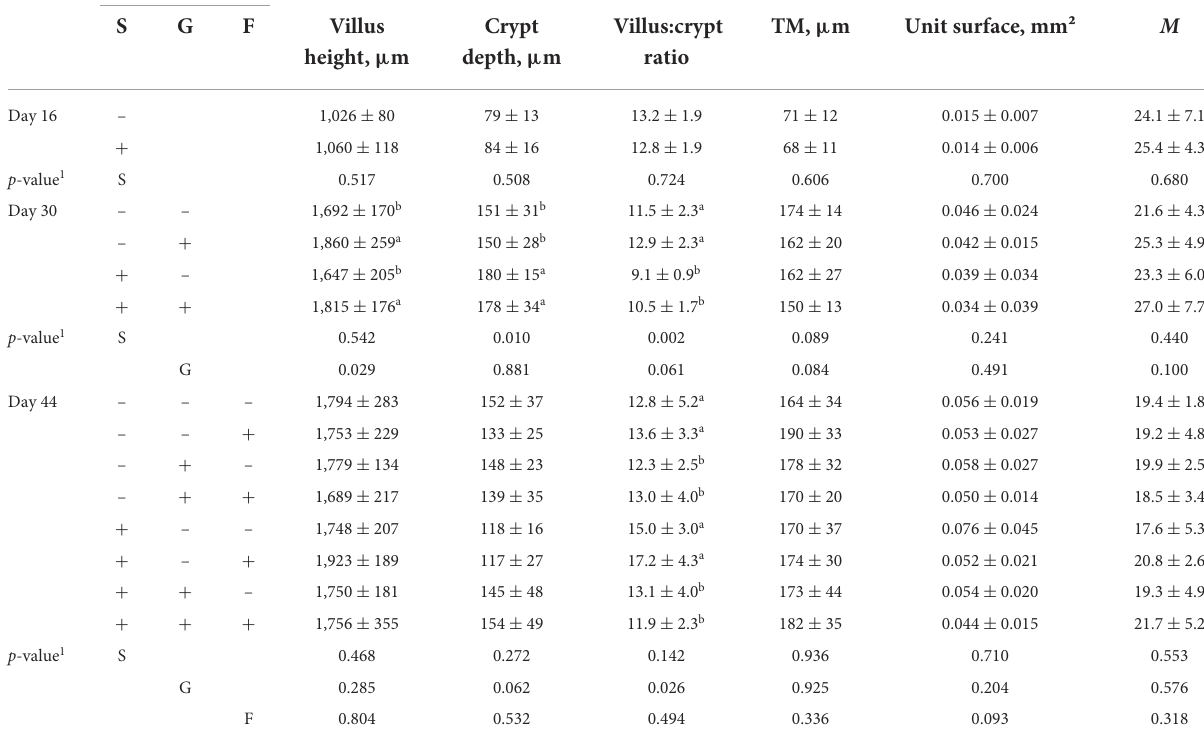
TABLE 3 The effect of chestnut tannins ( + : 2,000 mg/kg; –: 0 mg/kg) on villus height, crypt depth, villus:crypt ratio, tunica muscularis width, unit surface and mucosal amplification ratio of broiler chickens at day 16 (S), 30 (G) and 44 (F) of age.